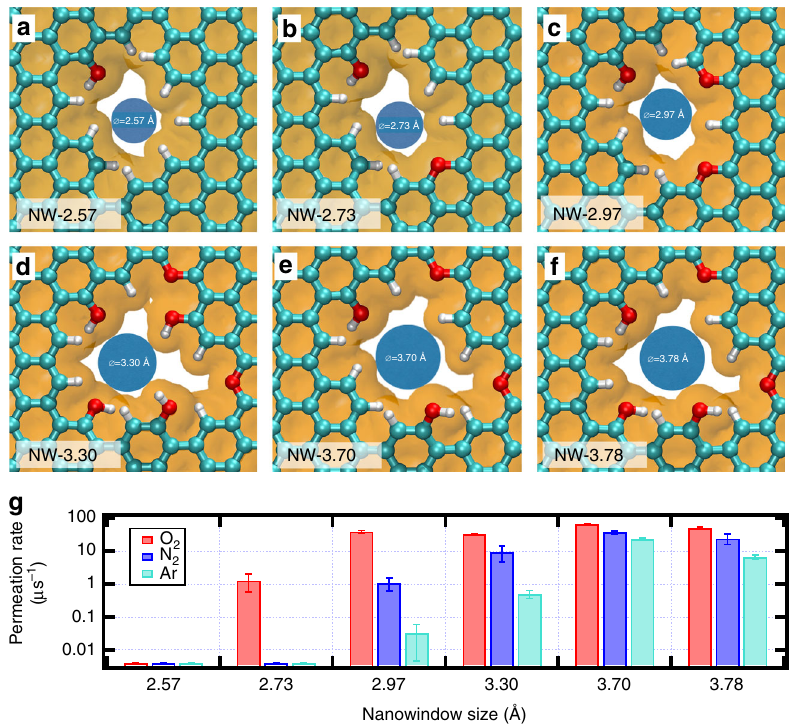
Fig. 1 Some quantum chemically allowed models of nanowindows. Each nanowindow is denoted as NW- d where d is van der Waals diameter of the opening in Å, represented by brown shadings. Cyan, red and white atoms are C, O, and H, respectively. Resulting sizes in Å were a 2.57; b 2.73; c 2.97; d 3.30; e 3.70; and f 3.78. g Permeation rate constants evaluated fi tting the average of many MD runs in a canonical ensemble to a fi rst order model. Temperatures are 90, 77, and 87 K for O 2 , N 2 , and Ar, respectively. Permeation rates barely shown indicate that no permeation events were observed during our simulations. Error bars represent uncertainty ± 1 SD. There is highly selective O 2 permeation through a nanowindow smaller than the O